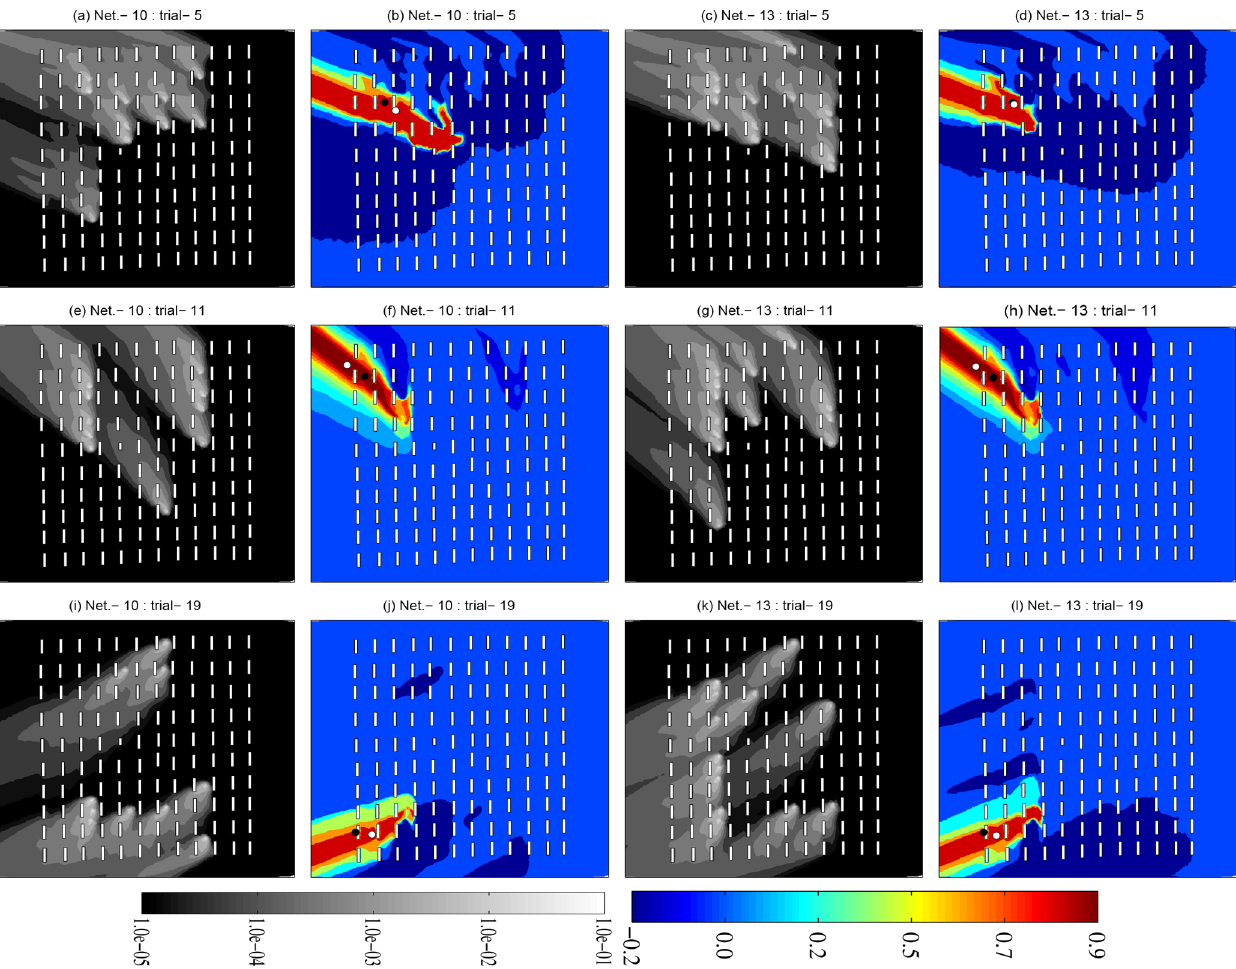
Figure 4. Isopleths of the renormalized weight function (w( x )) (gray in first and third columns) and the normalized source estimate function ( s n w ( x ) = s w ( x )/ max ( s w ( x ))) (colored in second and fourth columns) for both optimal networks of 10 and 13 sensors, respectively, for trials 5 (very stable), 11 (neutral), and 19 (stable). The black and white filled circles respectively represent the true and estimated source